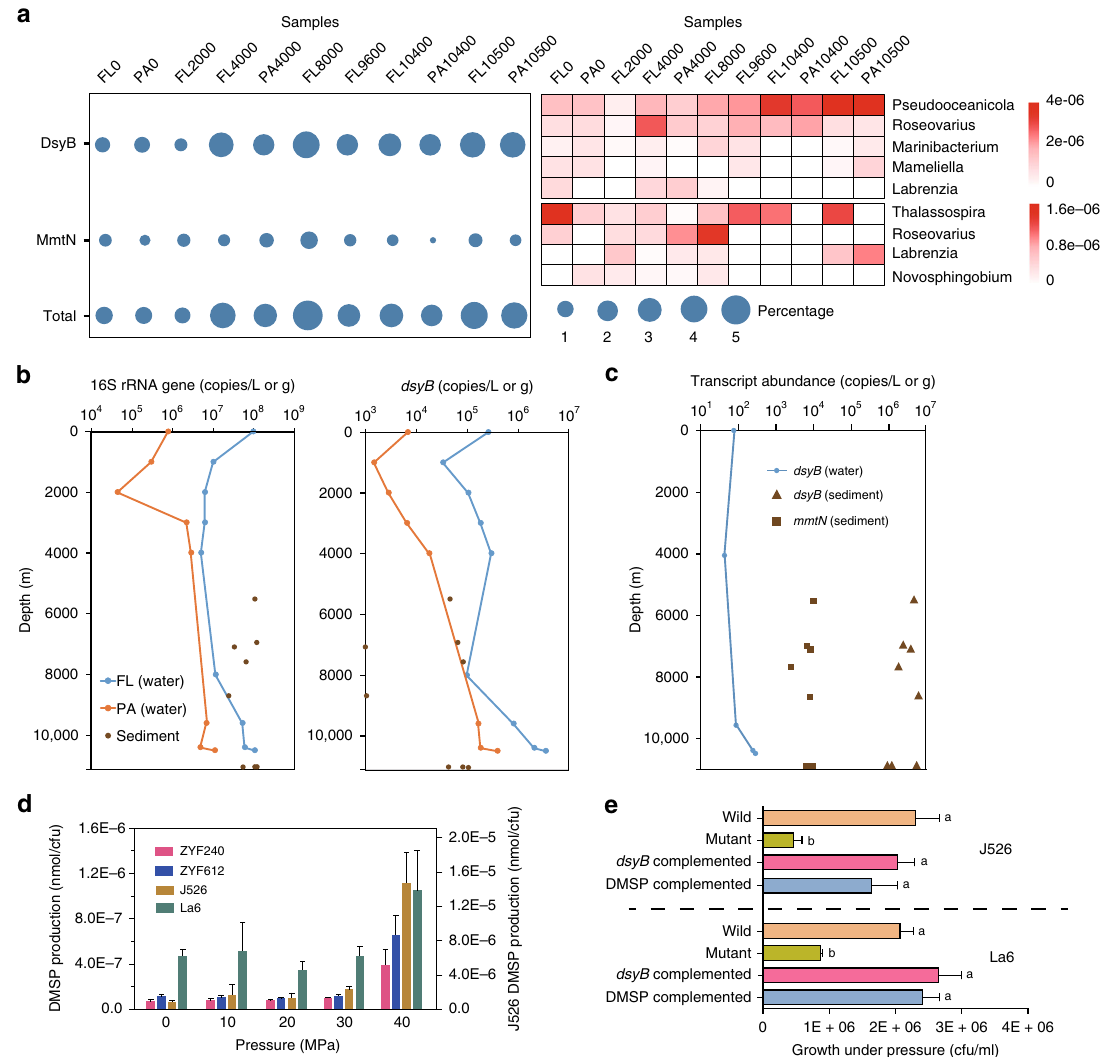
Fig. 2 The importance of DMSP synthesis genes in Challenger Deep samples. a Percentage of bacteria with DsyB and MmtN (left), and pro fi les of the bacterial communities harboring them (right) in depth-pro fi led samples determined by metagenomic analysis. Sample names are de fi ned by size fraction and sampling depth, e.g., FL10500 is the free-living fraction at 10,500 m. FL: free-living; PA: particle-associated. b Absolute abundance of 16S rRNA and dsyB gene copies in the seawater and sediment at various depths, determined by qPCR. c Transcript abundance of dsyB in FL water and sediment samples, and of mmtN in sediment from different depths. d The effects of hydrostatic pressure on DMSP production. Left Y axis indicate strains ZYF240 ( Pseudooceanicola nanhaiensis isolated from 8000 m seawater of the Mariana Trench), ZYF612 ( Labrenzia aggregata isolated from 9600 m seawater of the Mariana Trench), and Marinibacterium sp. strain La6. Right Y axis indicates Pelagibaca bermudensis strain J526. e The survival of DMSP-producing bacteria J526 and La6 (wild type), dsyB − mutant variants, dsyB − mutants containing cloned dsyB , and dsyB − mutant isolates supplied with DMSP, after incubation at 60 MPa for 10 days. Data in e , f are presented as means ±